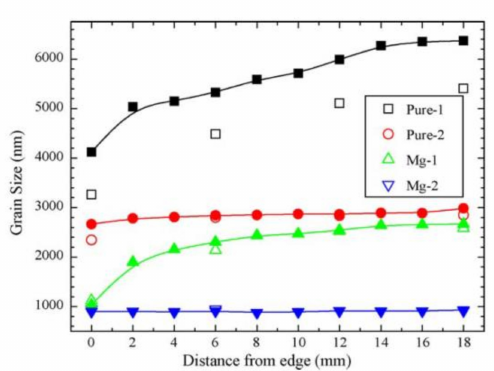
Figure 4. Example of the grain size distribution along radial direction for SPS sintered pure and Mg-doped alumina samples. Filled marks are taken from the sample middle and empty marks from the sample surface with respect to the sample thickness. All samples were sintered at 1350 ◦ C with a dwell time of 5 min. For the “-1” samples, the uniaxial sintering pressure of 100 MPa was applied during the full sintering cycle, while for “-2” samples the same uniaxial pressure starting to be applied (in a 1 min ramp) once the samples reached 1300 ◦ C. Pressure application through the whole sintering cycle promotes grain size inhomogeneities which are remarkably reduced in a two-step pressure profile. Solute drag and improved grain boundary sliding by Mg-doping further reduced the grain size inhomogeneities [51]. (reprinted with permission from